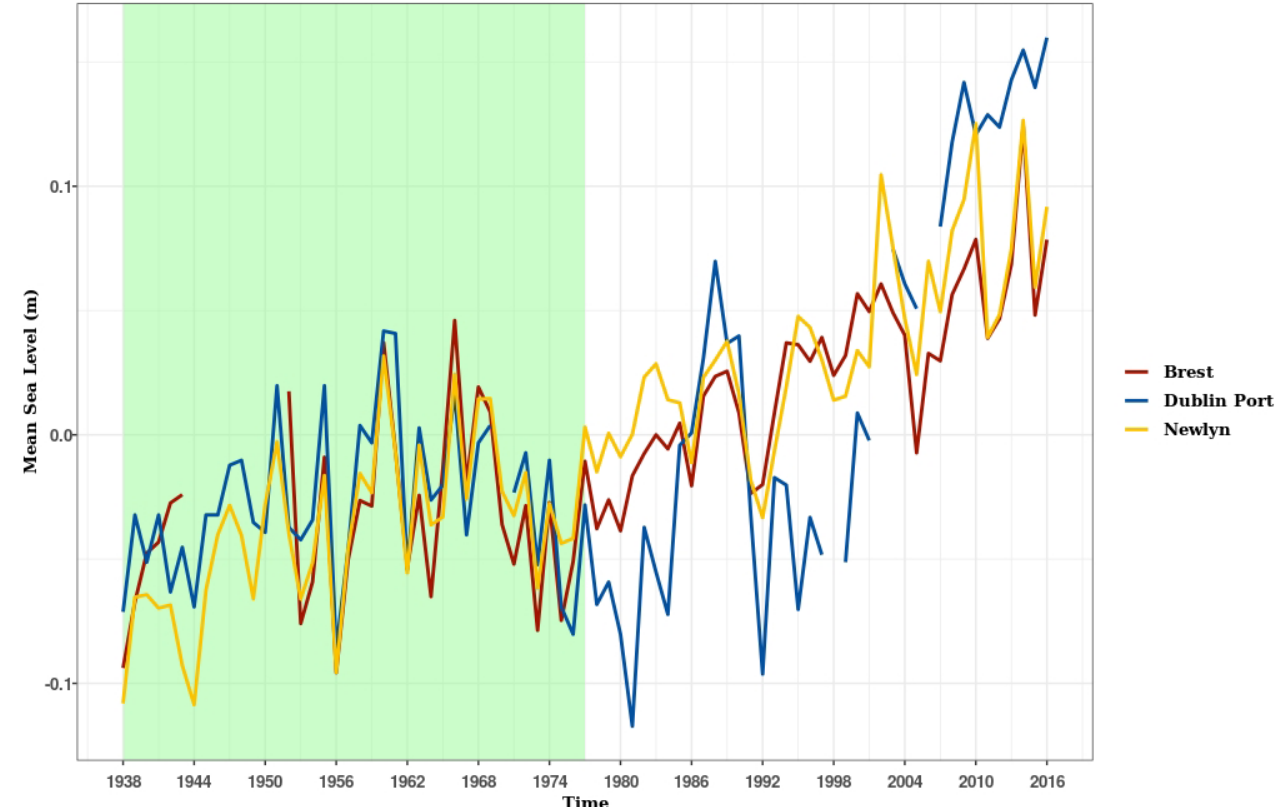
Figure 4. Yearly MSL values for Dublin Port, Newlyn and Brest. The green area shows our chosen time period, during which there is good agreement between Dublin Port and the other